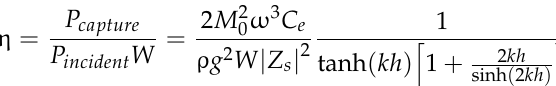
Figure 2. An example of the boundary element method (BEM) mesh for the Duck at floating state No. 8.